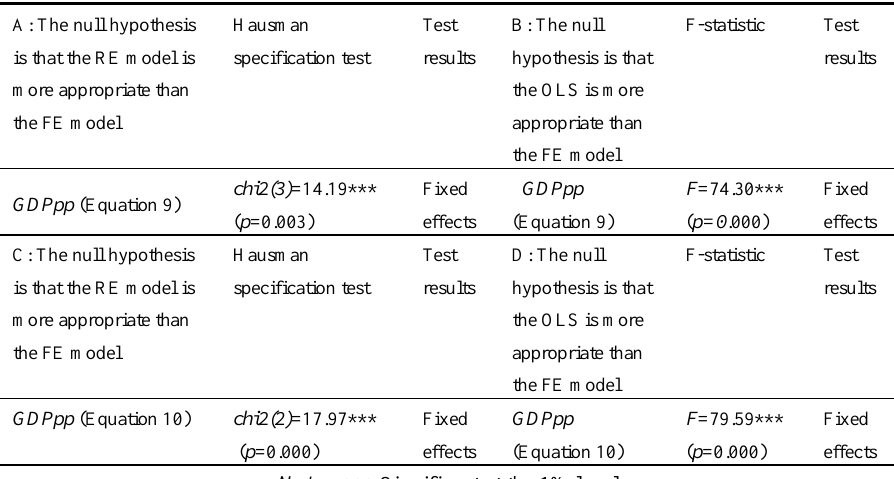
Table 2 : The results of F-Test and Hausman specification